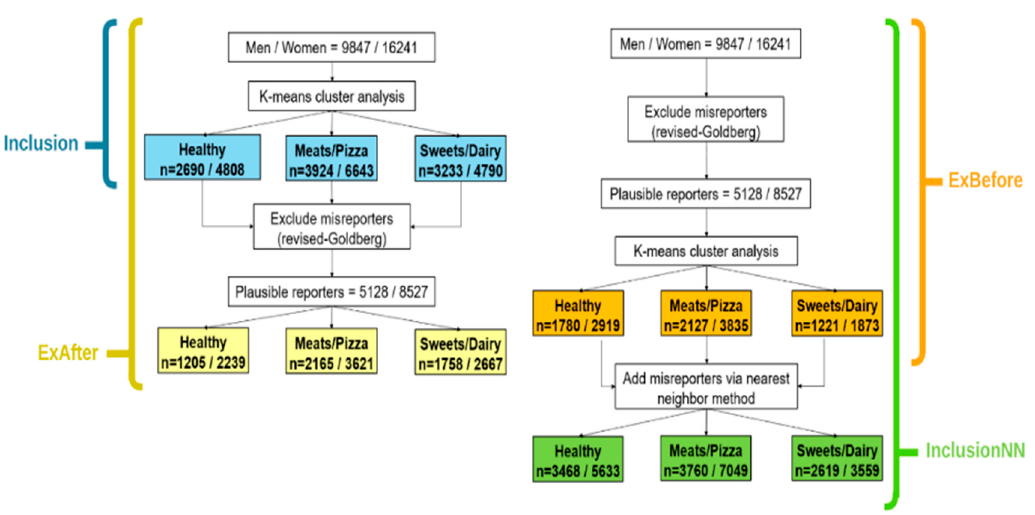
Figure 1. Flow chart illustrating different methods for accounting for potential misreporting of energy intake.